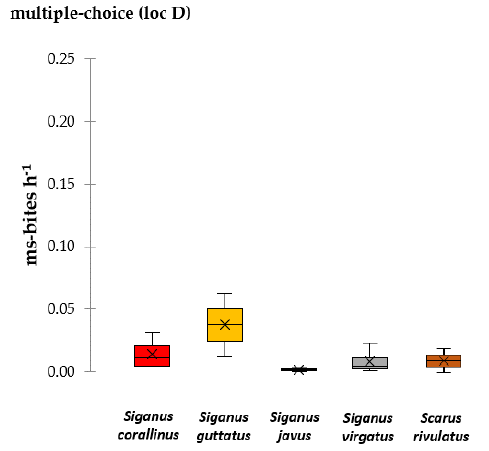
Figure 5. Bite rates (ms-bites h − 1 ) for recorded fish species in multiple choice-assays (loc D) in 2018. Fish species are color-coded. The boxplot shows the median and 25% quantile, the black cross indicates the mean.